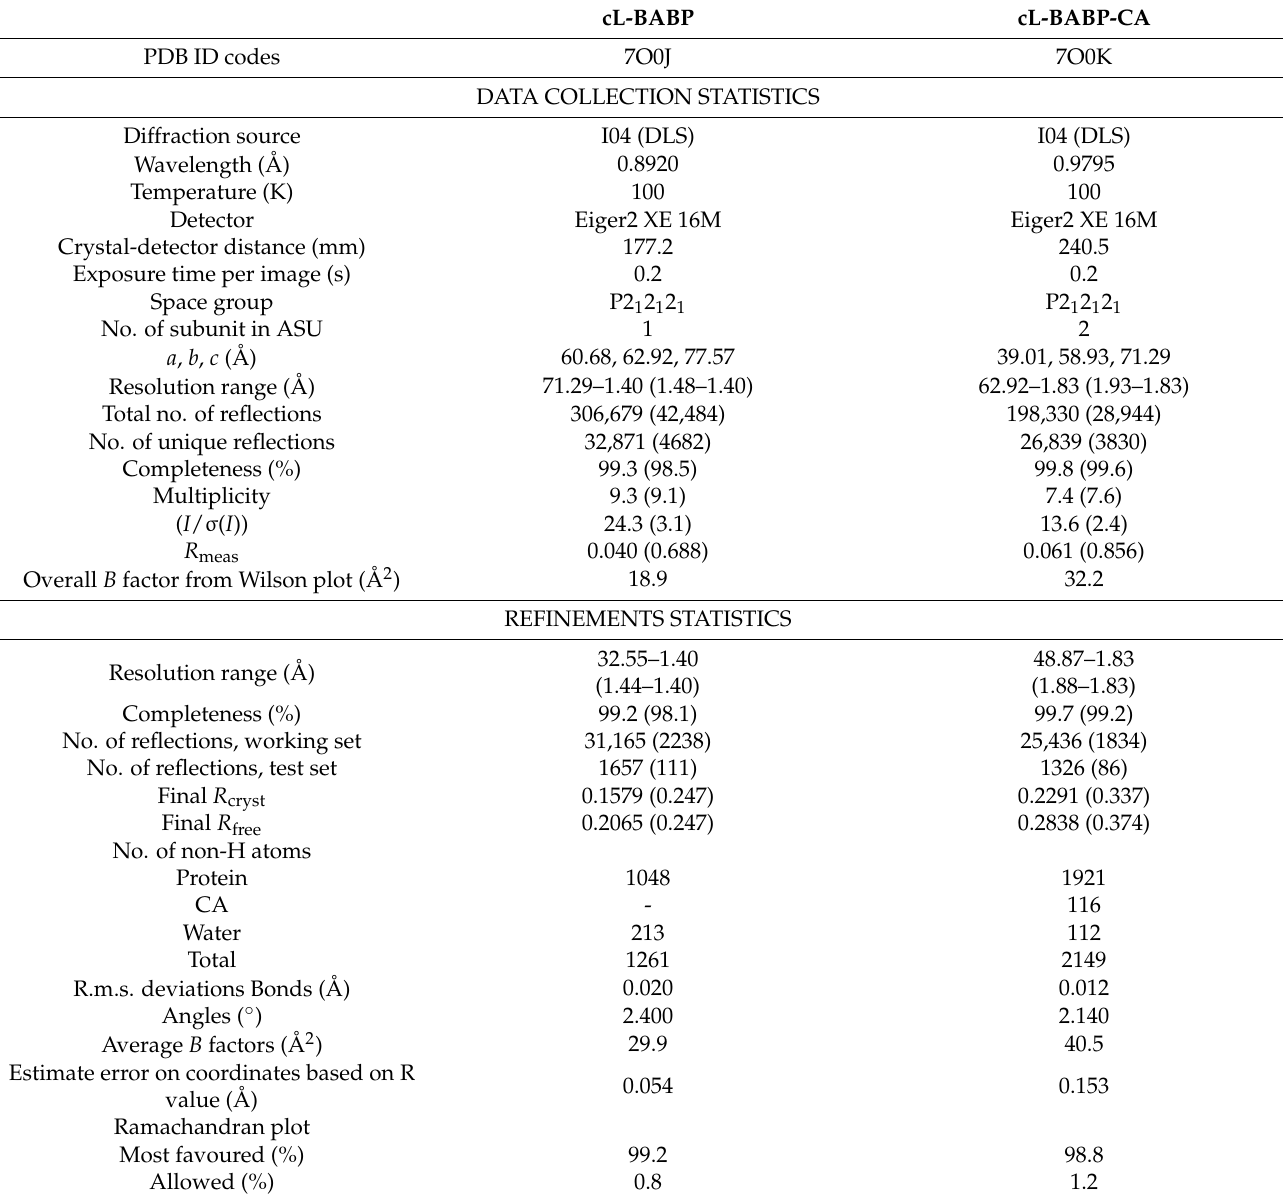
Table 2. Data collection and refinement statistics. Values for the outer shell are given in